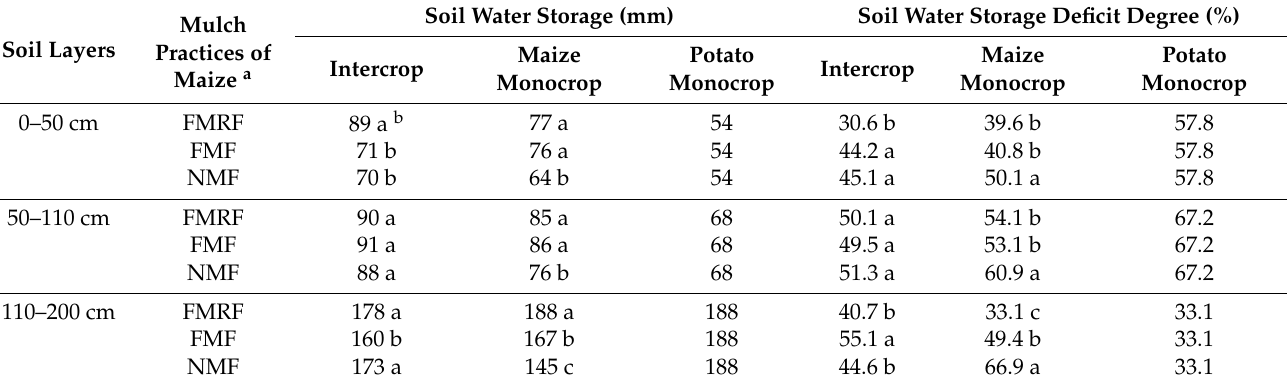
Table 5. Average soil water storage and soil water storage deficit degree for the 0–50, 50–110, and 110–200 cm soil layers at the harvesting of the intercropping system compared with monocrop during